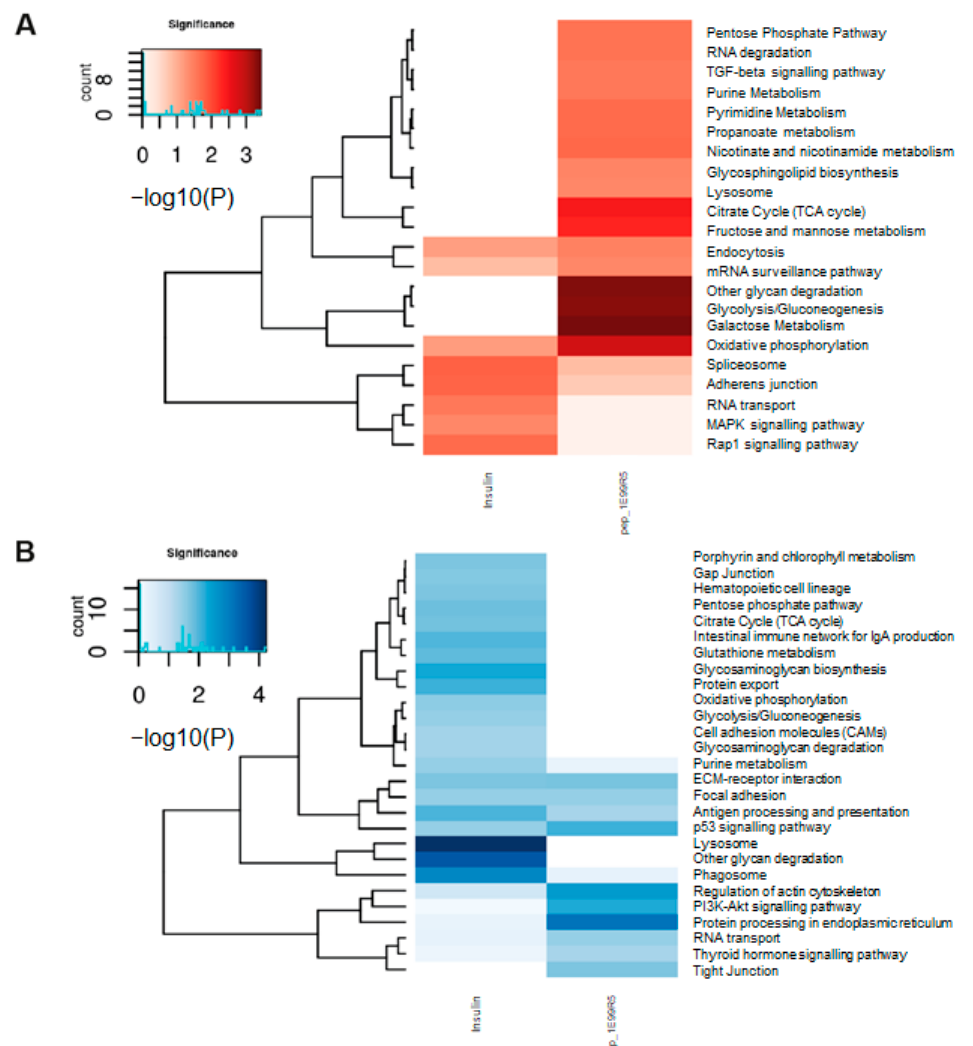
Figure 7. Kyoto Encyclopedia of Genes and Genomes (KEGG) pathway enrichment analyses of pep_1E99R5 and insulin. Representation of the KEGG pathway enrichment of significantly differentially expressed genes for insulin and pep_1E99R5 compared to untreated. Gene lists were filtered using raw p -value < 0.05 and fold change ≥ 1.3. The significance of a given KEGG pathway is assessed with raw p -value < 0.05. ( A ) Heatmap showing significantly downregulated (red) enrichment in KEGG pathways and ( B ) heatmap showing significantly upregulated (blue) enrichment in KEGG pathways (deeper colour indicates increased significance). Heatmaps present log-transformed raw p -values. Enrichment analyses were performed for each treatment (insulin and pep_1E99R5) separately and then brought together for comparison. Colour gradients indicate significance; the darker the colour, the more significant the result is.